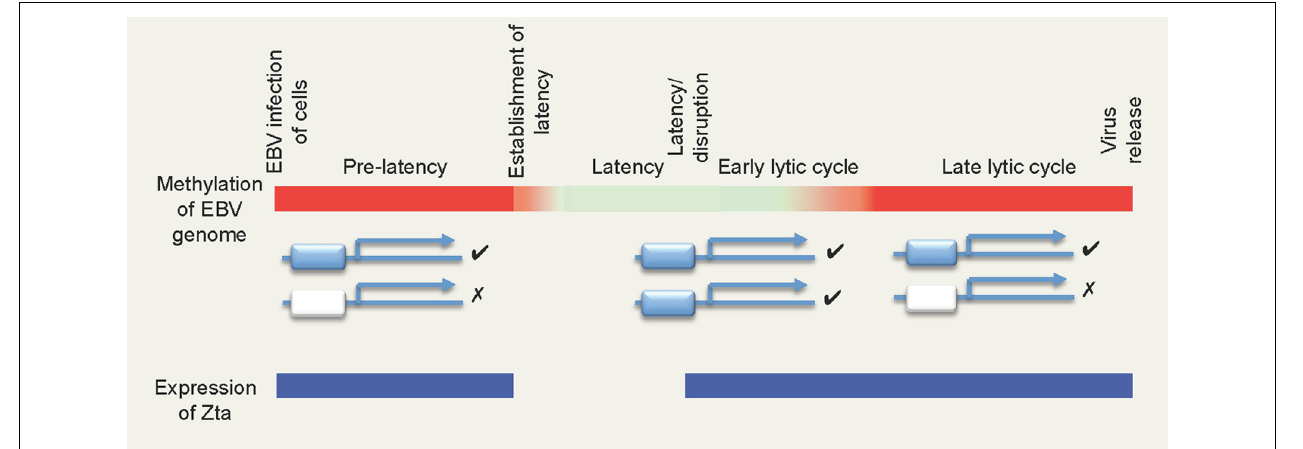
FIGURE 1 |The biphasic DNA methylation cycle of the EBV genome and its impact of ZREs. The colored bar depicts the methylation state of EBV genome during different phases of the viral life cycle, with non-methylated DNA in red and methylated DNA represented in green.Two types of